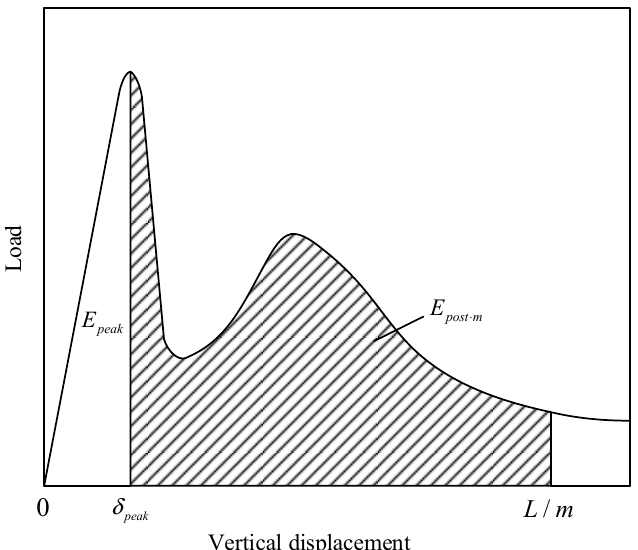
Figure 13. Definition of flexural toughness in this